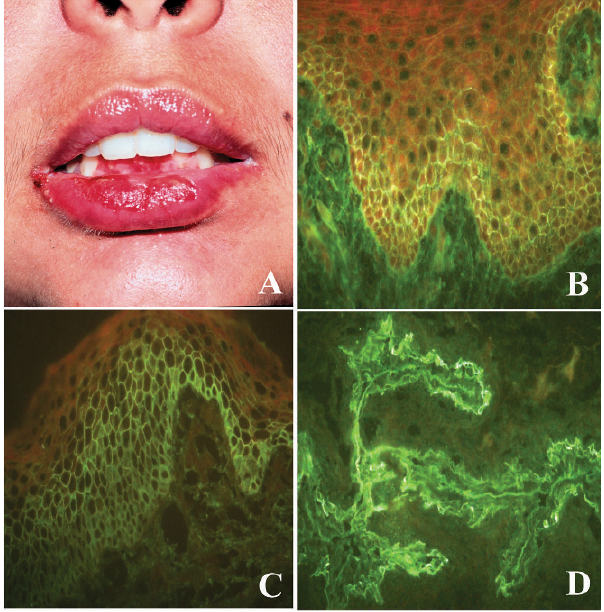
Figure 1 - (A) Clinical aspects of the lesions of a PV patient and (B) the results of direct immunofluorescence demonstrating inter- cellular IgG at the basal layers of the epidermis ( 6 400); (C) indirect immunofluorescence using human foreskin as a sub- strate showing intercellular intraepidermal IgG deposits ( 6 400); and (D) indirect immunofluorescence using rat bladder epithe- lium as a substrate demonstrating intercellular intraepithelial IgG deposits ( 6 400).